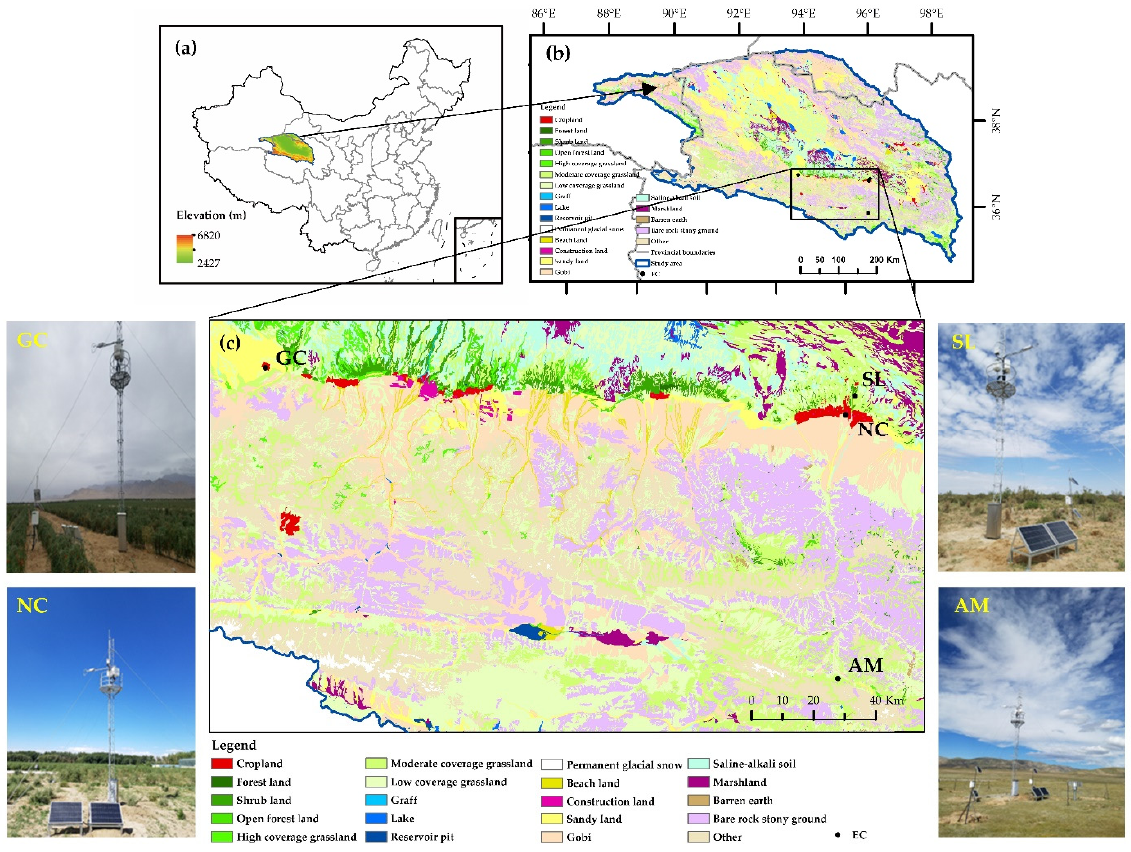
Figure 1. ( a ) The location and elevation of the study area and ( b , c ) spatial distribution of 4 observation sites in Qaidam Basin in 2020.